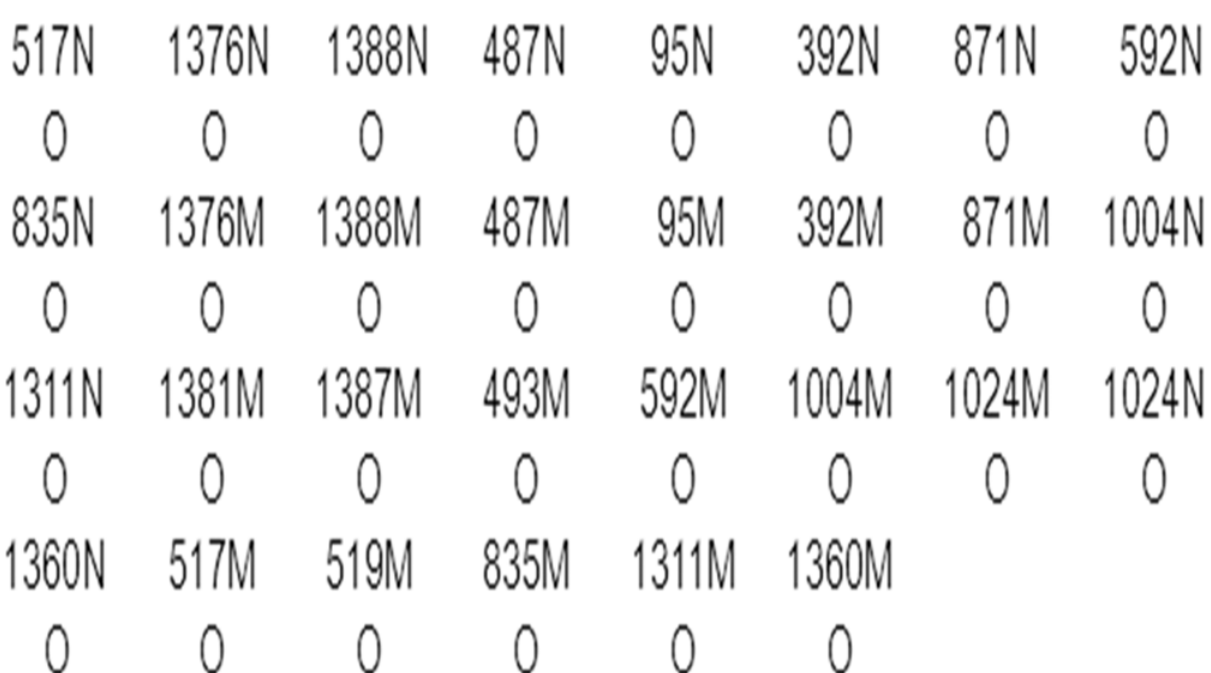
Fig 1. Layout of the probes ’ dotting in the nylon strip designed for the reverse dot blot assay. N denotes the wild-type probes corresponding to each mutant probes (denoted at each mutation).